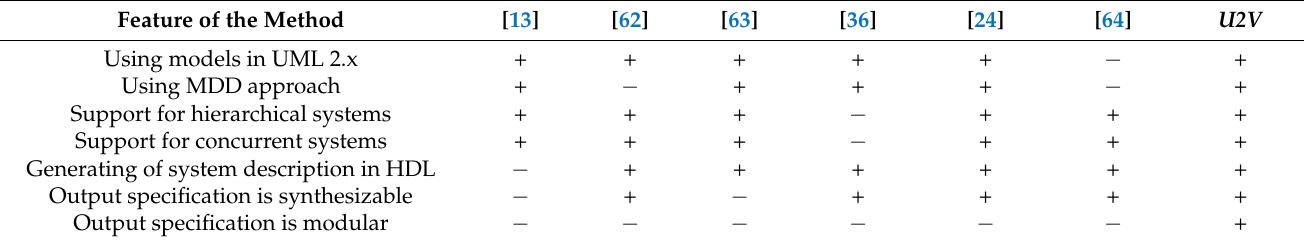
Table 1. A comparison of the proposed method (including the U2V tool) with selected methods.